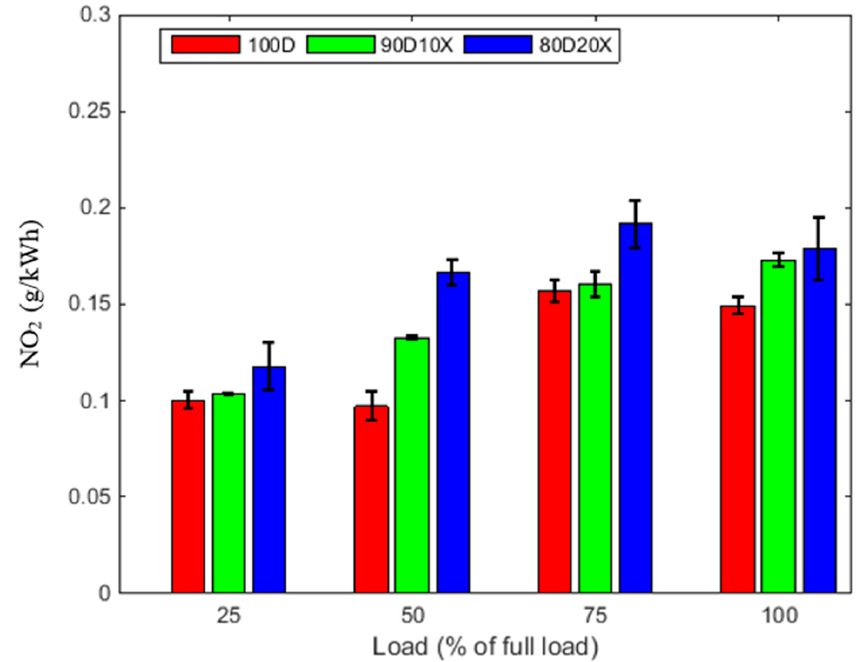
Figure 7. Brake specific NO 2 emission with engine loads for diesel and DOP blends.